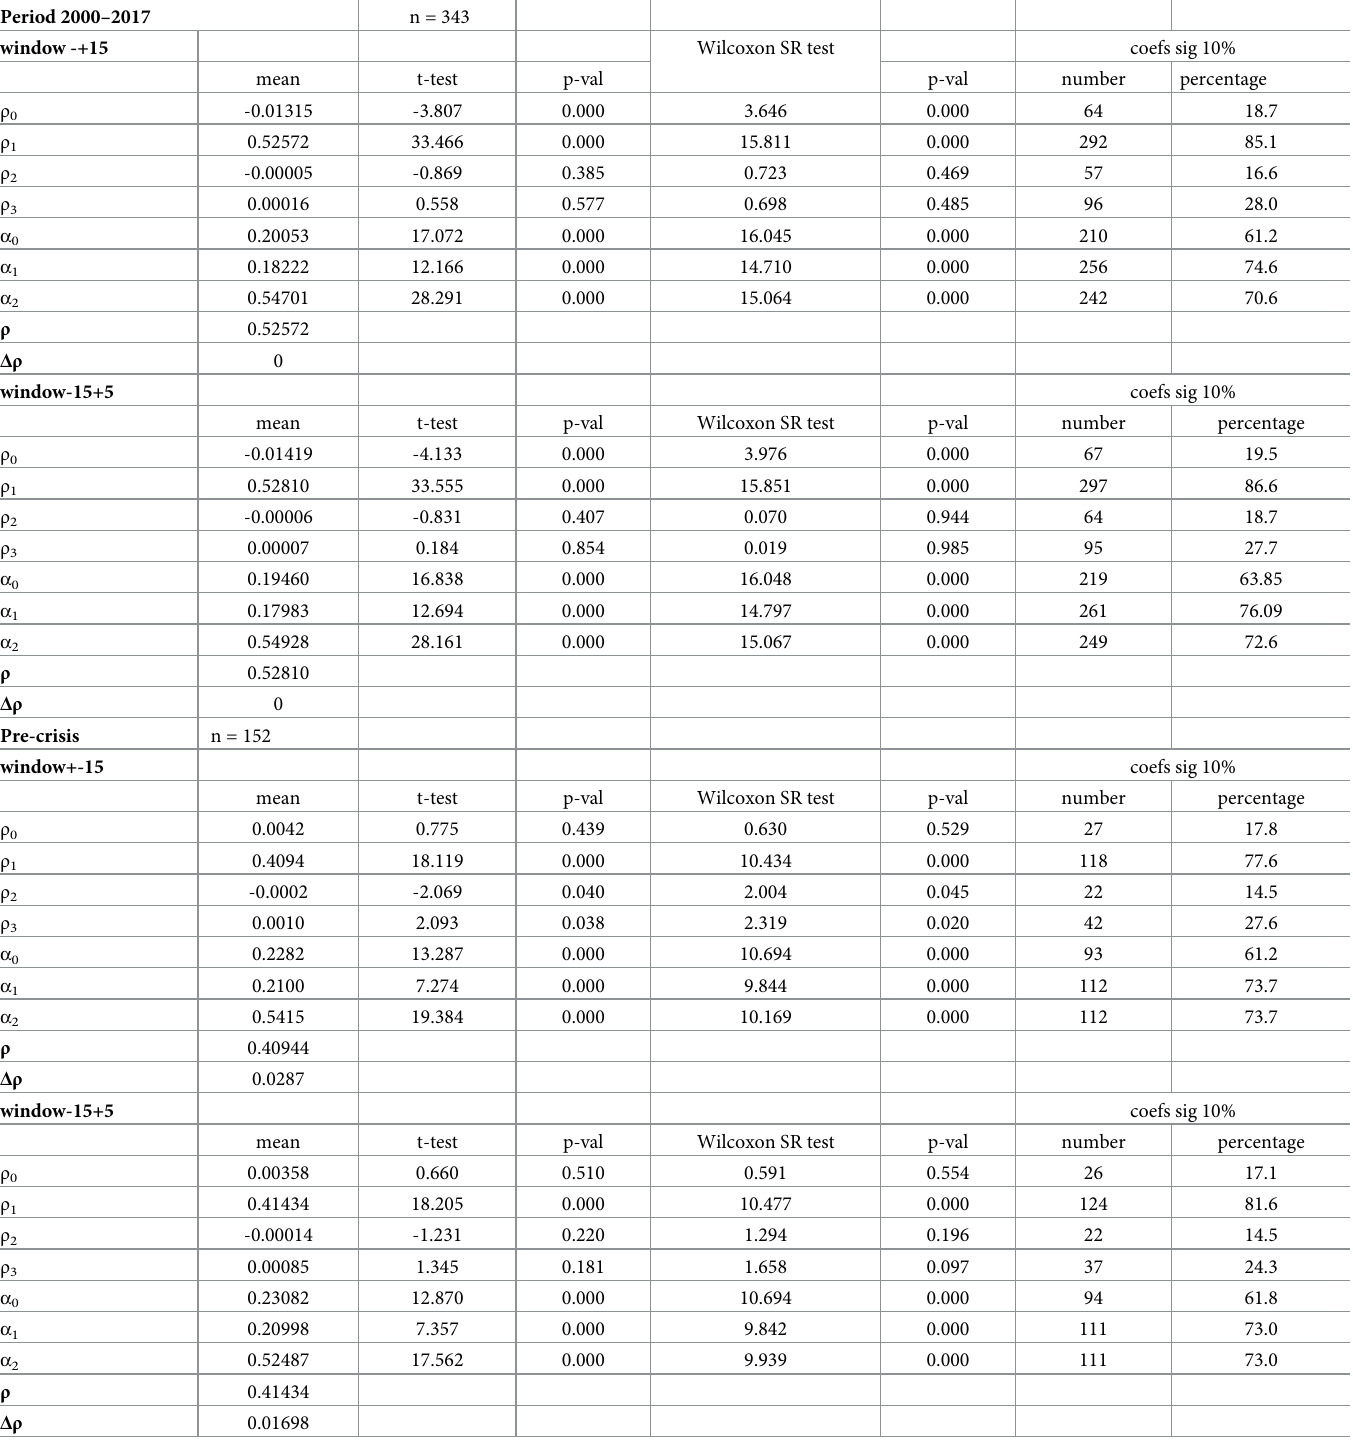
Table 6. Summary results-normalized: